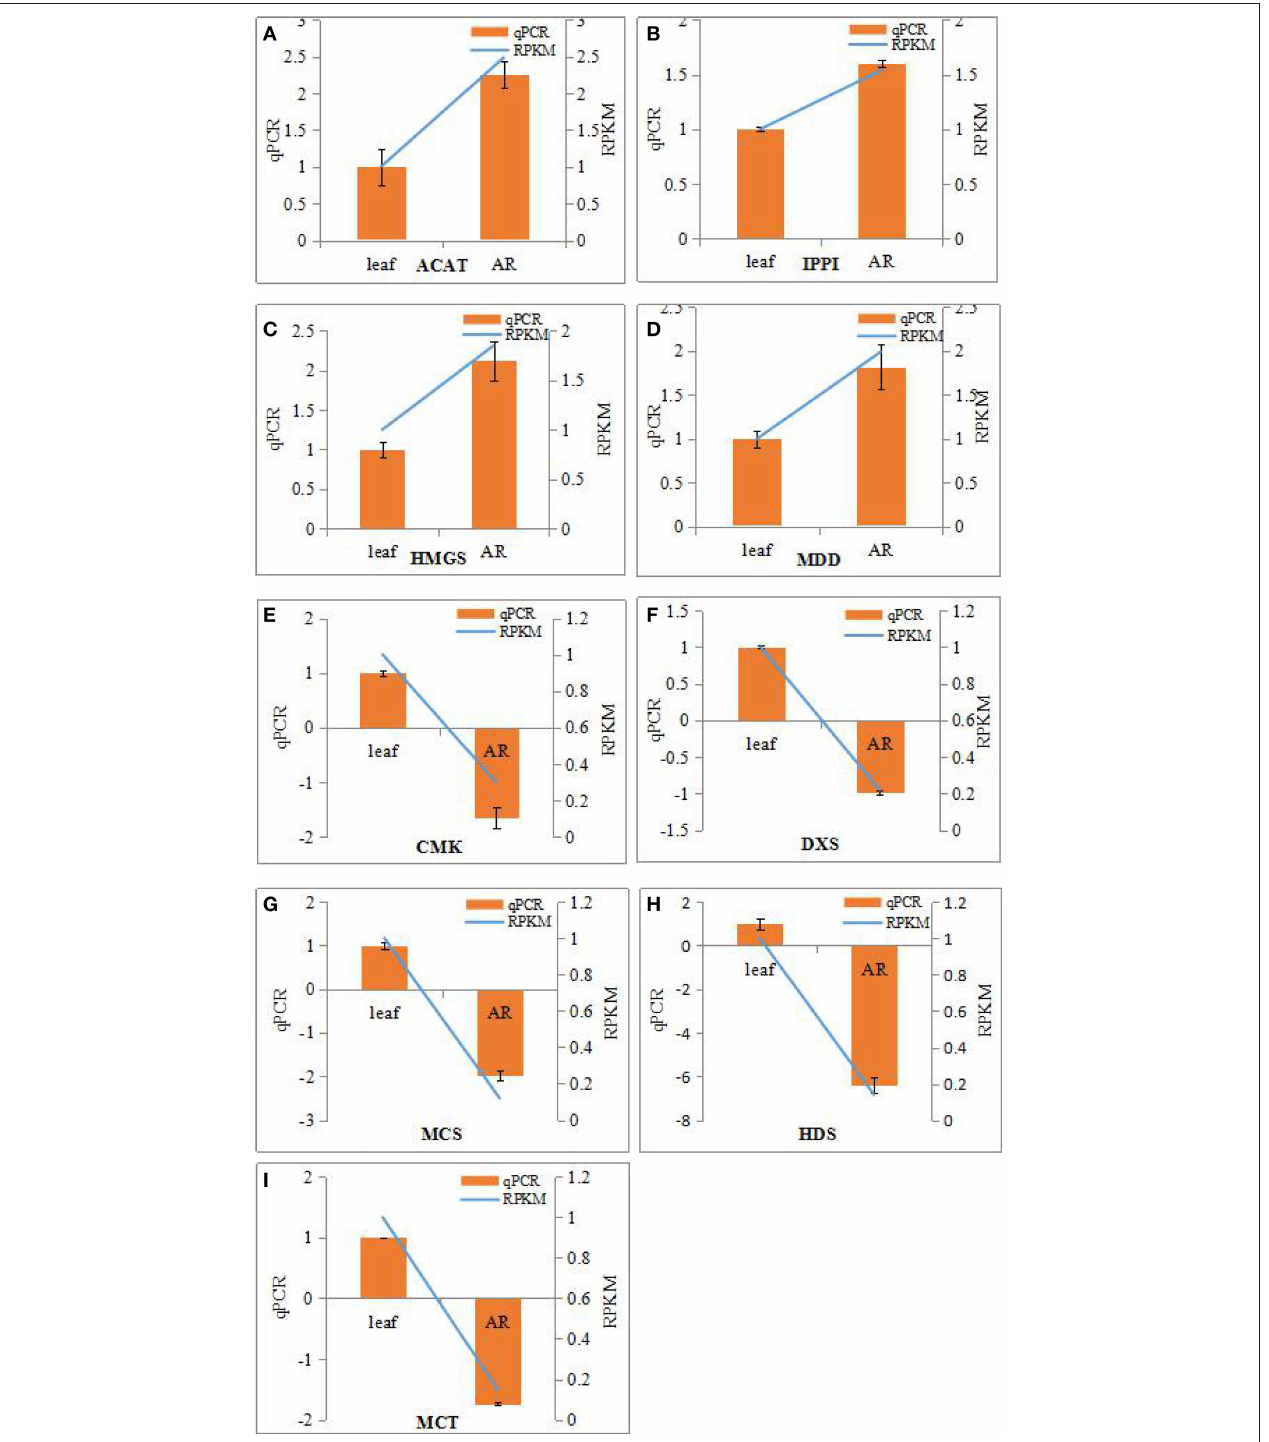
FIGURE 5 | Real-time PCR analysis of differentially expressed genes (DEGs) involved in IPP biosynthesis from MVA and MEP pathways in the adventitious roots and leaves of Periploca sepium . Real-time PCR analysis of ACAT (A) , IPPI (B) , HMGS (C) , MDD (D) , CMK (E) , DXS (F) , MCS (G) , HDS (H) , MCT (I) . The genes selected for validation were RNA-seq data. The left vertical axis showed relative expression levels as measured by qPCR values while the right vertical axis showed relative RPKM value. Experiments were conducted in triplicate. Error values for qPCR data at each sample time indicate standard deviation (SD).